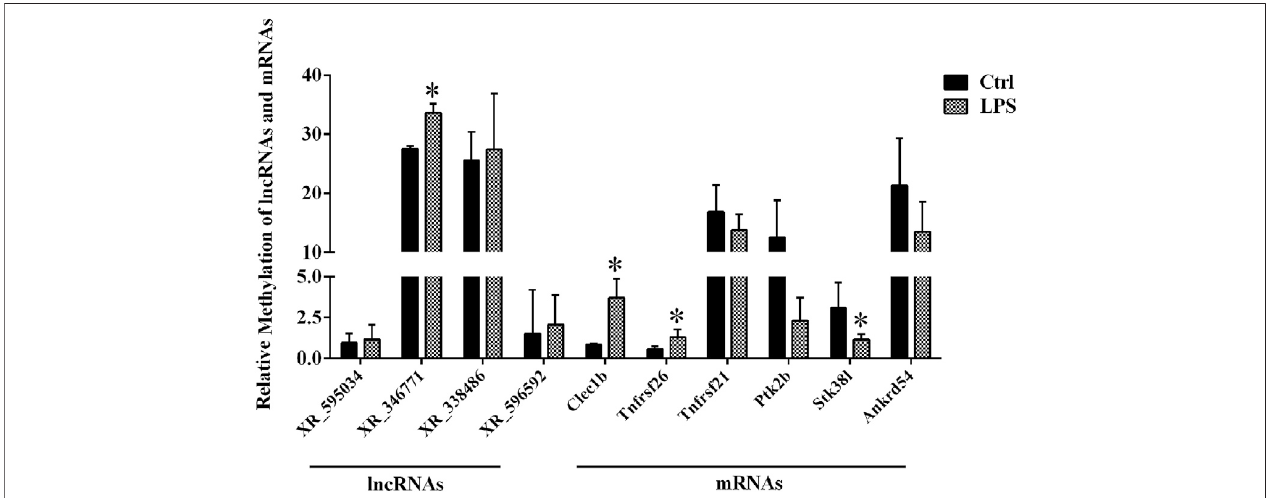
FIGURE4| M 6 Asingle-basesiteqPCRwasusedtocon fi rmthemicroarraydataforthetopfourmethylatedlncRNAsandtopsixmethylatedmRNAsinleftventricle tissue between the LPS and control groups. * p < 0.05 versus the Ctrl group. Ctrl, control; LPS,